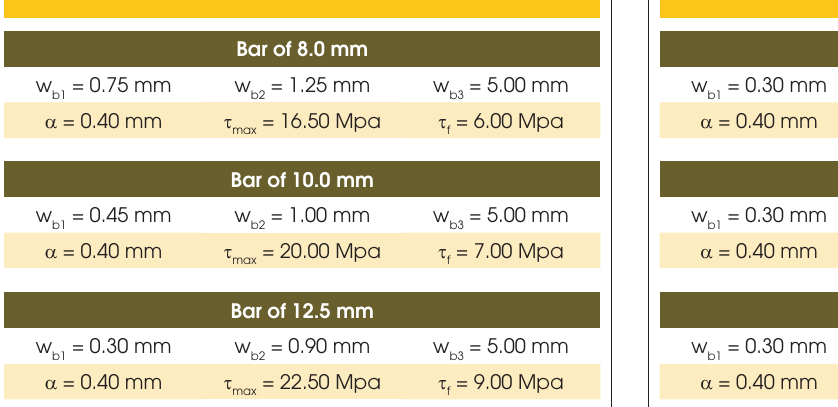
Table 5 – Parameters for the Eligehausen bond law for concrete